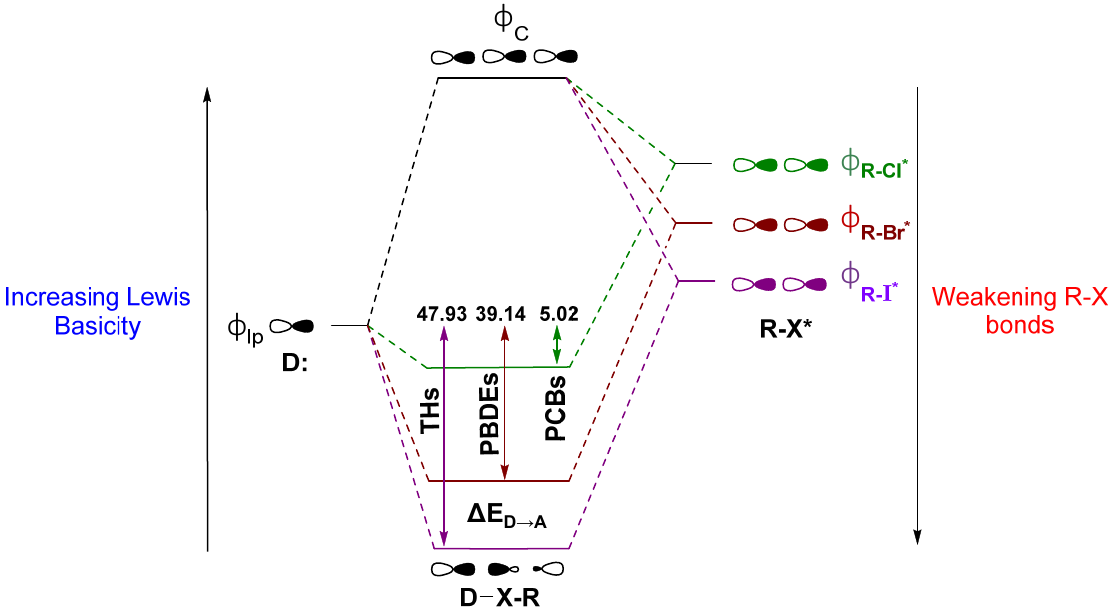
Figure 4. XB as described by the molecular orbital (MO) model showing the interaction between a lone pair of a donor and the R ‒ X antibonding orbital, alongside the corresponding average stabilization of the Se donor lone pair by THs, PBDEs, and PCBs as determined by Natural Bond Orbital (NBO) Δ E D → A analysis. Units are kcal mol − 1 . Adapted from reference